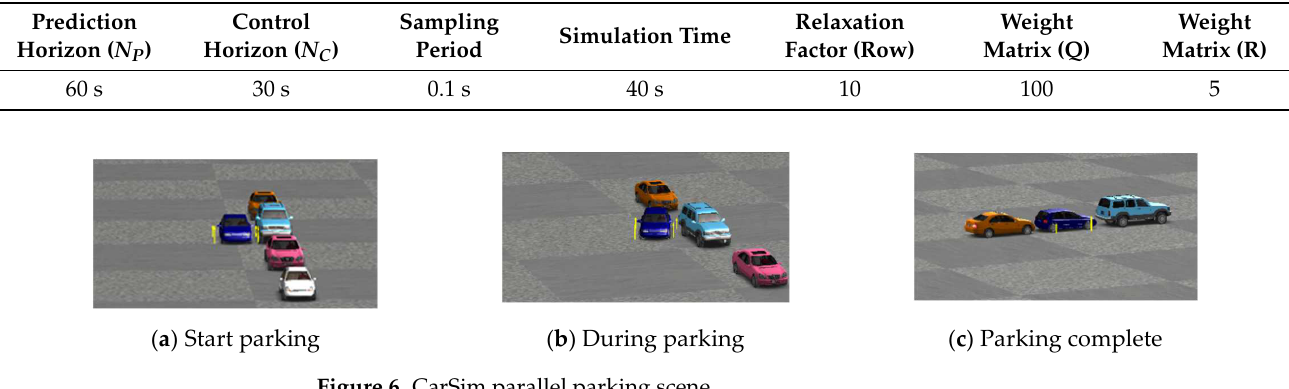
Table 3. MPC controller basic parameters.